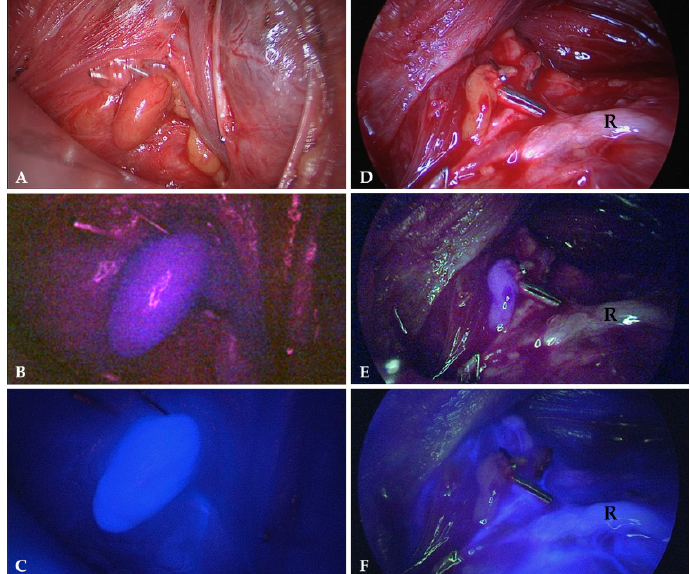
Figure 4. Parathyroid glands exposed to normal white light ( A , D ), NIR light displaying their autofluorescence ( B , E ) and NIR light 2 min after intravenous application of 5mg indocyanine green ( C , F ). The gland on the left displays a strong fluorescence verifying a good vascularity ( C ) while the gland on the right is non-fluorescent ( F ) indicating avascularity (R = recurrent laryngeal nerve).